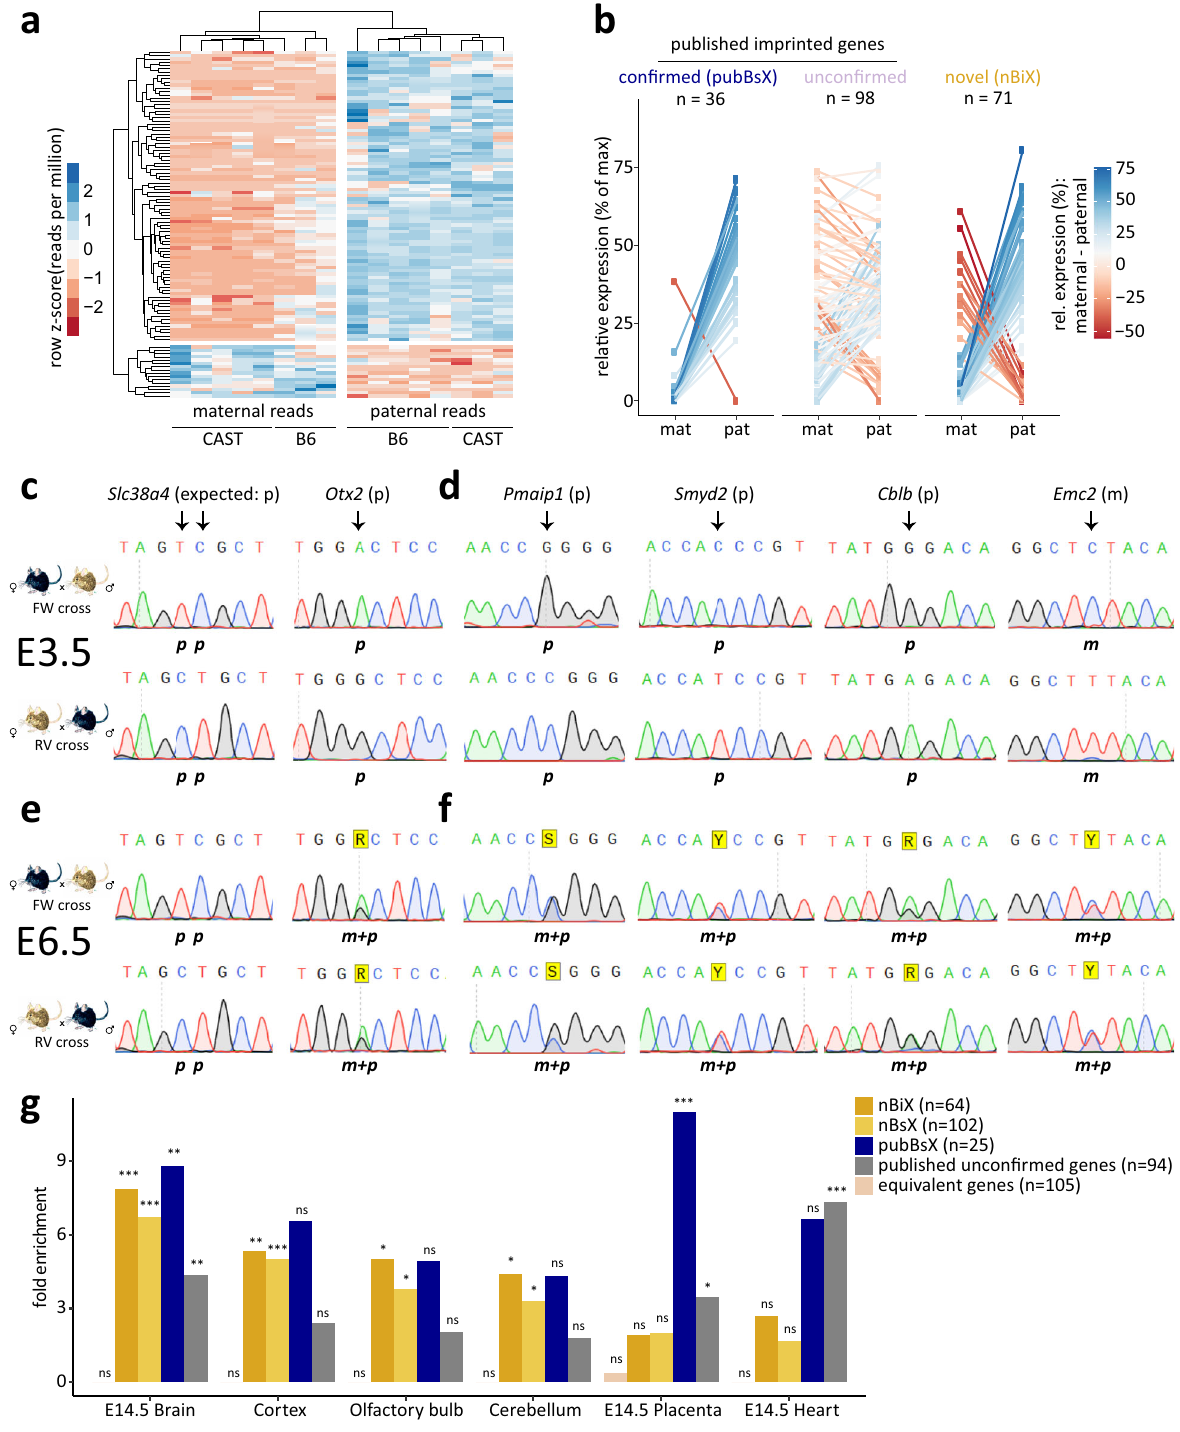
Fig. 1 Parent-of-origin-speci fi c gene expression in blastocysts. a Heatmap showing row-normalised expression values of all 105 blastocyst imprinted expressed (BiX) genes. Colour scale indicates Z-scores based on reads per million. Maternal and paternal reads for the same sample are shown in separate columns. b Distribution of SNP-containing RNA-seq reads in genetically distinguishable blastocysts on embryonic day 3.5 (E3.5). Comparisons are shown between maternal and paternal alleles in different gene groups [con fi rmed published imprinted genes (pubBsX), published uncon fi rmed imprinted genes, novel blastocyst imprint expressed (nBiX)]. Expression values were normalised to the maximum read count per gene and the mean of all replicates is shown. c – f Electropherogram showing RT-PCR Sanger sequencing-based analysis of allele-speci fi c expression of con fi rmed published imprinted genes Slc38a4 and Otx2 at E3.5 ( c ), of indicated nBiX genes at E3.5 ( d ), of con fi rmed published imprinted genes Slc38a4 and Otx2 at E6.5 ( e ) and of allele-speci fi c expression of indicated nBiX genes at E6.5 ( f ). g Barplot showing tissue-speci fi c gene enrichment for different gene groups (nBiX, nBsX, pubBsX, published uncon fi rmed and equivalently expressed genes), based on analysis with the R package TissueEnrich 64 . FDR-adjusted p values were calculated using a hypergeometric test. Only tissues with a signi fi cant (adj. p <0.05) enrichment in at least one group of genes are shown. * p <0.05; ** p <0.01; *** p <0.001; ns, not signi fi cant; n , number of genes belonging to each group that are present in the database used for tissue enrichment analysis. Source data are provided as Source Data fi